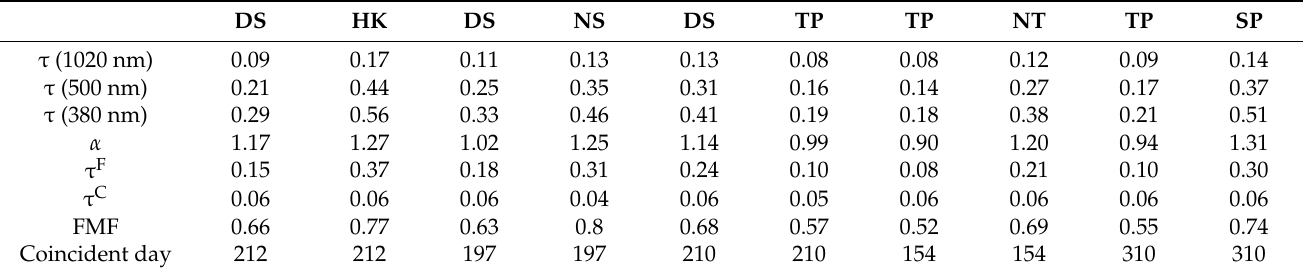
Table 3. Mean value of τ , α (440–870 nm), τ F (500 nm), τ C (500 nm) and FMF obtained over Dongsha (DS), NSPO (NS), Hong Kong (HK), Taiping (TP), Nha Trang (NT) and Singapore (SP). Here, the same time series of stations are compared with Dongsha Island and Taiping Island from 1